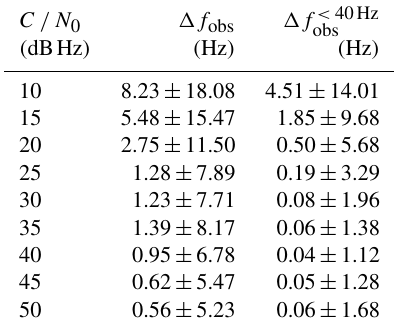
Table 2. Mean and standard deviations of (cid:49)f obs (centre column) for nine values of the carrier signal-to-noise density ratio C /N 0 between 10 and 50dBHz; averaging bin size is 5dBHz. The statis- tics is based on all PRNs shown in Fig. 14. The third column lists the corresponding result, neglecting frequency deviations larger than 40Hz. C /N